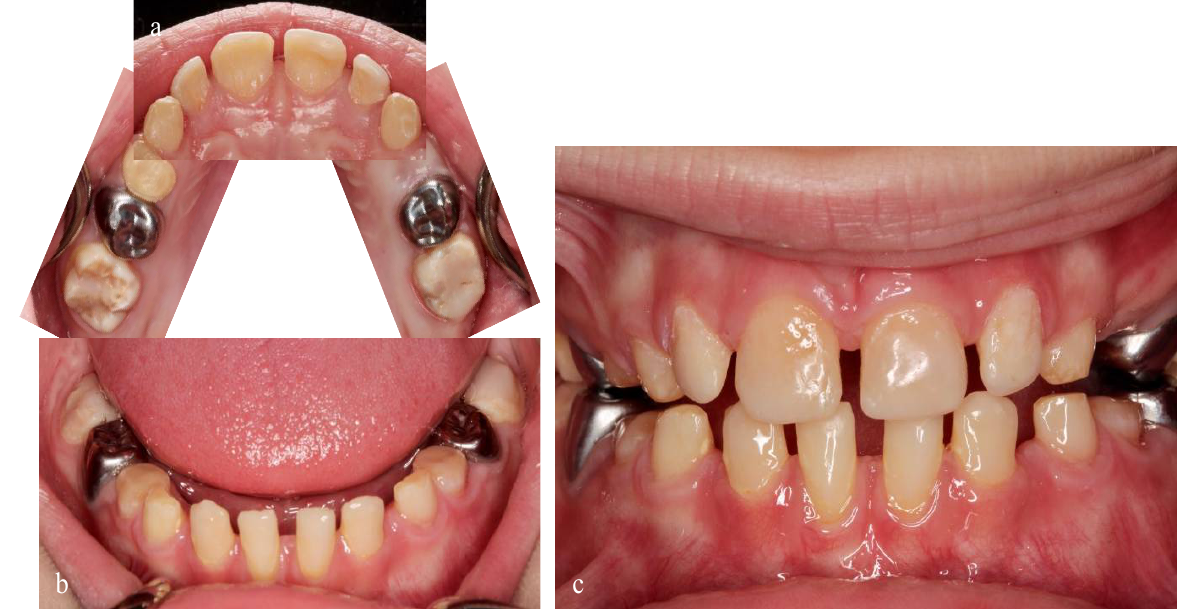
Figure 6. Follow-up 6 months after restoration under general anesthesia: ( a ) upper teeth; ( b ) lower teeth; ( c ) front teeth. All restorations in situ, no abnormalities.